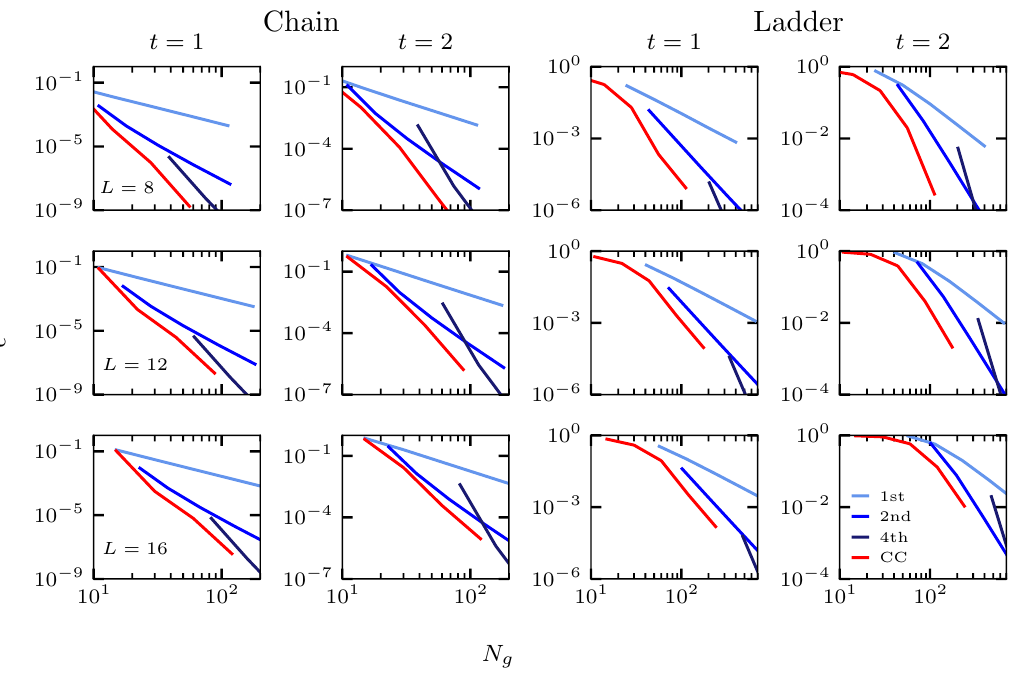
Figure 4: The infidelity ε versus gate count N for the time evolution operator of the g Heisenberg model on a chain (left panels) and ladder (right panels) in log-log scale. The first and third columns are for t = 1 while the second and fourth columns are for t = 2. The top panels are for L = 8 and a time evolution MPO with χ = 256, the middle panels are for L = 12 with χ = 150, and the bottom panels are for L = 16 with χ = 100. The blue curves represent the Trotter circuits and the red curve represents the compressed circuit